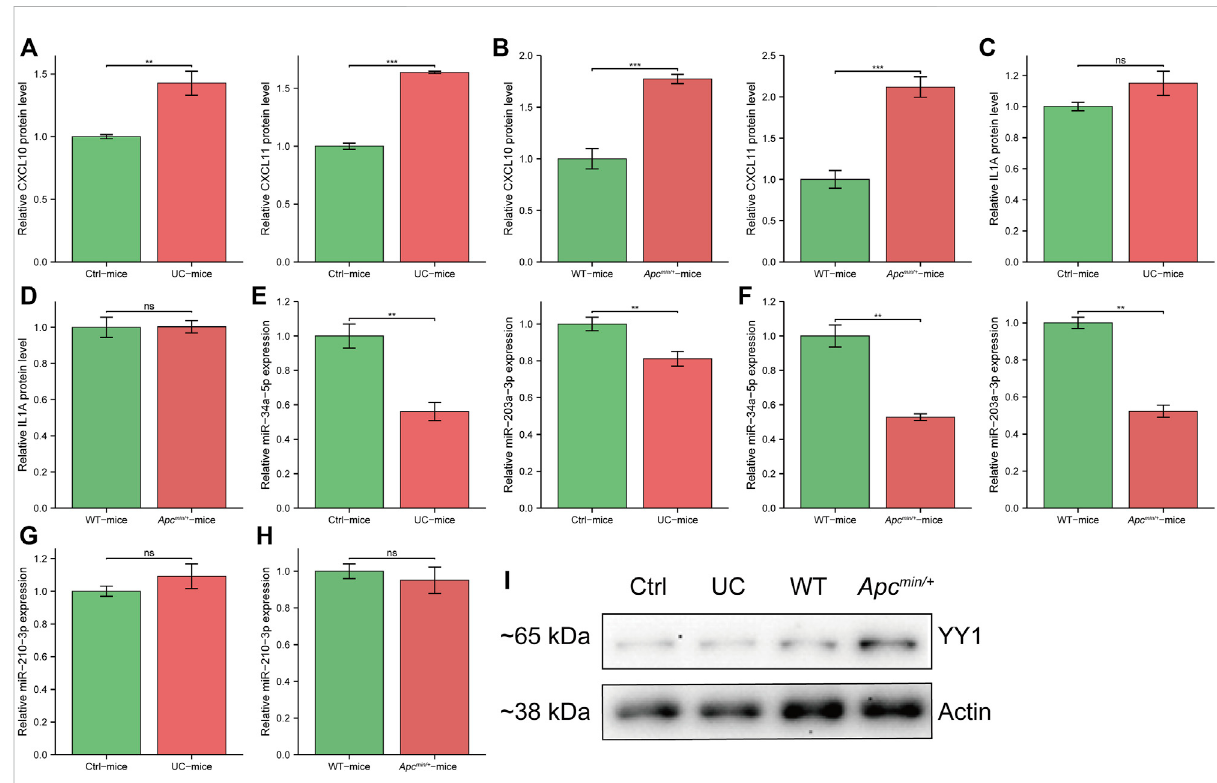
FIGURE 6 Theexpression ofsurvival-hub genesandinteracted regulatory signatures in vivo . (A) cytokinearraytodetect CXCL10 and CXCL11inulcerative colitis (UC) mice and controls ( n = 3, per group), respectively. (B) cytokine array to detect CXCL10 and CXCL11 in APC min/+ mice and wild type (WT) ( n = 3, per group), respectively. (C) cytokine array to detect IL1A in UC mice and controls ( n = 3, per group). (D) cytokine array to detect IL1A in APC min/+ mice and WT ( n = 3, per group). (E) qRT-PCR for miR-34a-5p and miR-203a-3p in UC mice and controls ( n = 6, per group), respectively. (F) qRT-PCRformiR-34a-5pandmiR-203a-3pin APC min/+ miceandWT( n =6,pergroup),respectively. (G) qRT-PCRformiR-210-3pin UCmiceandcontrols ( n =6,per group). (H) qRT-PCRfor miR-210-3pin APC min/+ miceandWT ( n =6,per group). (I) Westernblotfor YY1expression in different groups. Ctrl, control mice for UC model. WT, wild type mice. *, p < 0.05; **, p < 0.01, ***, p < 0.001. Abbreviation: Ctrl, control; UC, ulcerative colitis; WT, wild